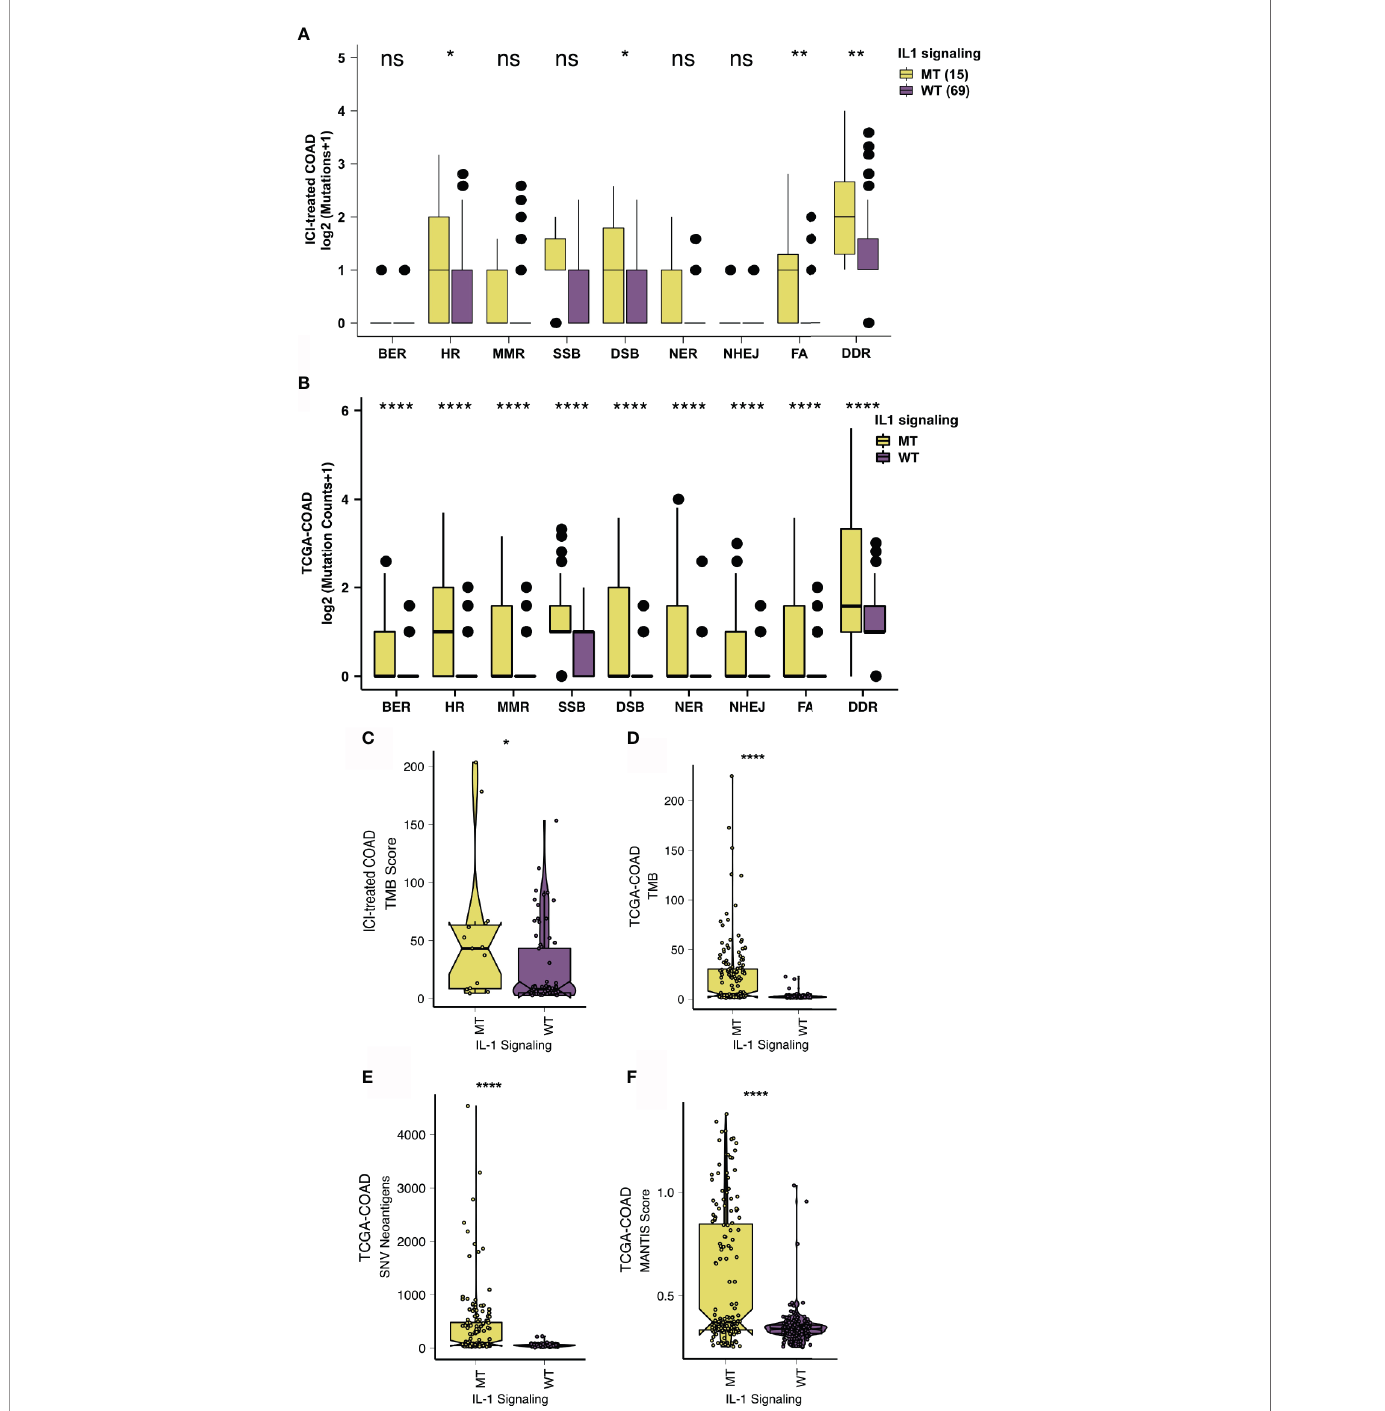
FIGURE 6 | IL-1-MT COAD is associated with enhanced tumor immunogenicity. Comparison of the mutation counts of nine DNA damage-related signaling pathways between IL-1-MT and IL-1-WT tumors in the ICI-treated COAD (A) and TCGA-COAD (B) cohorts. Comparison of the TMB between IL-1-MT and IL-1-WT tumors in the ICI-treated COAD (C) and TCGA-COAD (D) cohorts. Comparison of the NAL between IL-1-MT and IL-1-WT tumors in the TCGA-COAD cohort (E) . Comparison of the MANTIS score between IL-1-MT and IL-1-WT tumors in the TCGA-COAD cohort (F) . (*P < 0.05; **P < 0.01; ****P < 0.0001; ns, not signi fi cant; Mann-Whitney U